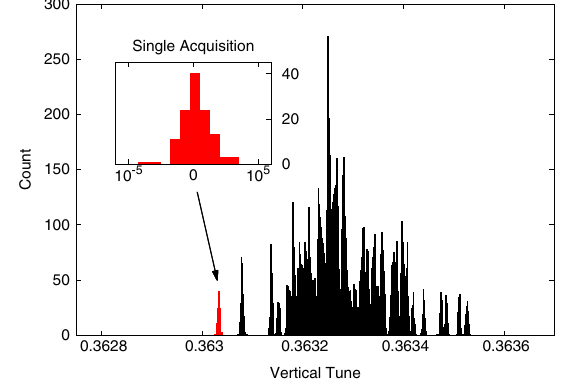
FIG. 2. Turn-by-turn vertical beam position measurements for the standard operation and zero chromaticity lattice. In the standard operation case (upper plot) a fast damping along with the characteristic pulsating amplitude is observed while the zero chromaticity case (lower plot) has an almost purely exponential decay.